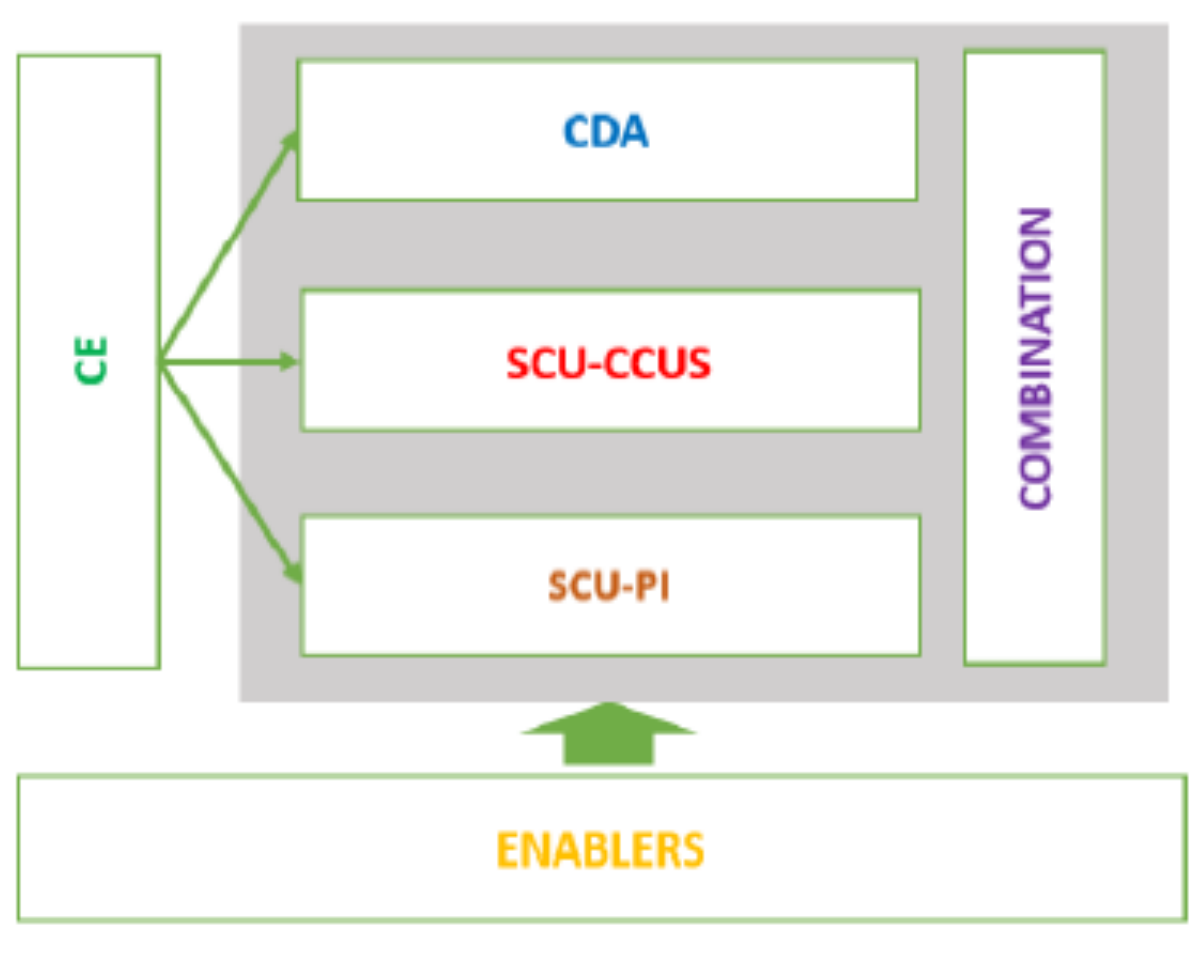
Figure 2. Areas of interventions and their interactions.